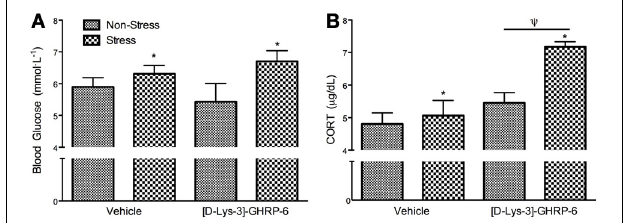
FIGURE 3 | (A) Body weight at the end of the 3 week chronic social defeat paradigm, and (B) the change of body weight during the stress period. All values are expressed as mean ± s.e.m. ∗ p < 0 . 05 relative to animals receiving vehicle infusions.